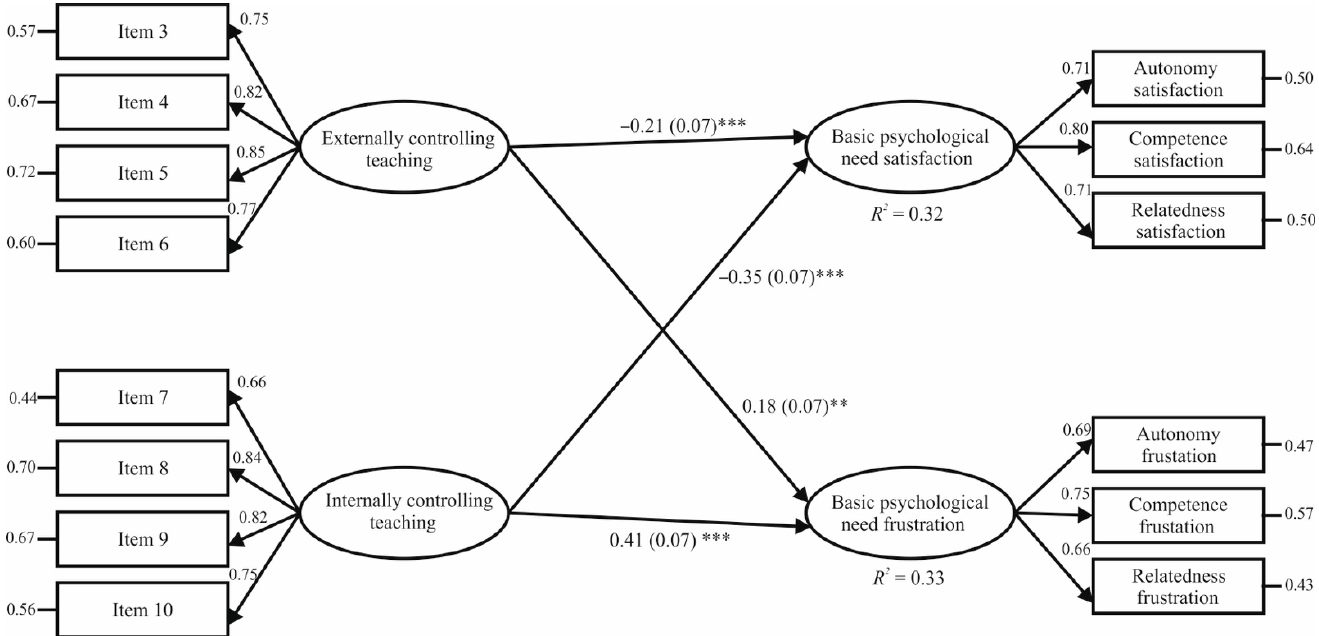
Figure 2. Relationships between externally and internally controlling teaching and need satisfaction and frustration in PE. *** p < 0.001, ** p < 0.01. Note: The numbers in parenthesis display the standard error estimated by bootstrapping. The correlation between externally and internally controlling teaching was r = 0.74, while the correlation of error terms between BPN satisfaction and frustration was r = − 0.58.